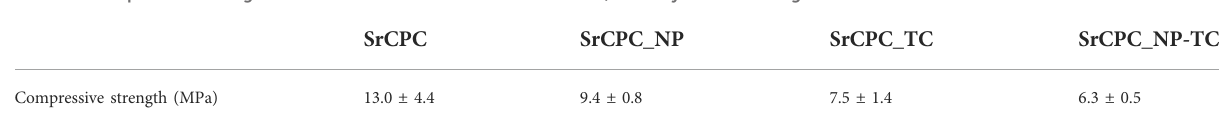
TABLE 2 Compression strength of cements with and without NPs or TC, at 7 days after soaking in HEPES at 37 °